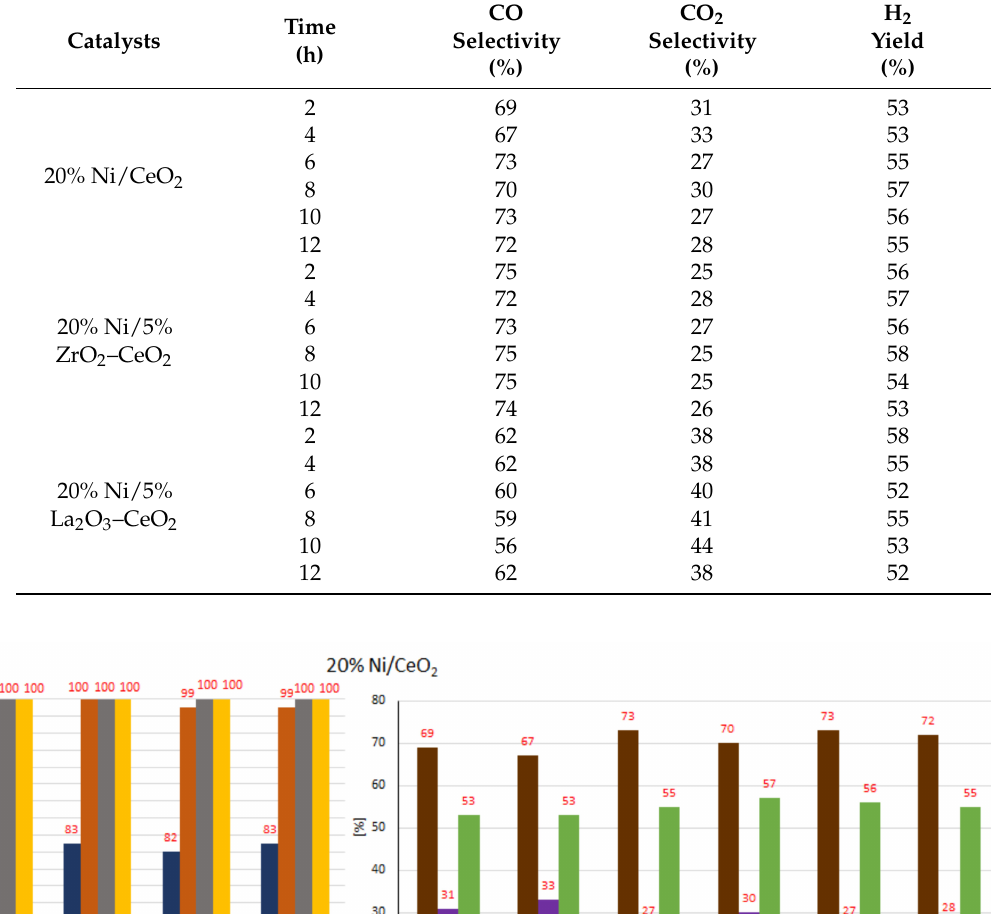
Table 8. The hydrogen yield and selectivity values to CO and CO 2 obtained in the stability tests in the oxy-steam reforming of liquefied natural gas (LNG) performed over 12 h time-on-stream using supported nickel catalysts.